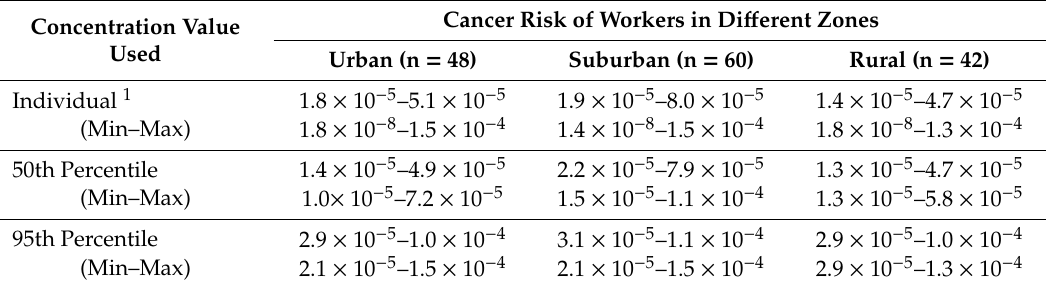
Table 2. The average lifetime cancer risk classified by zone.